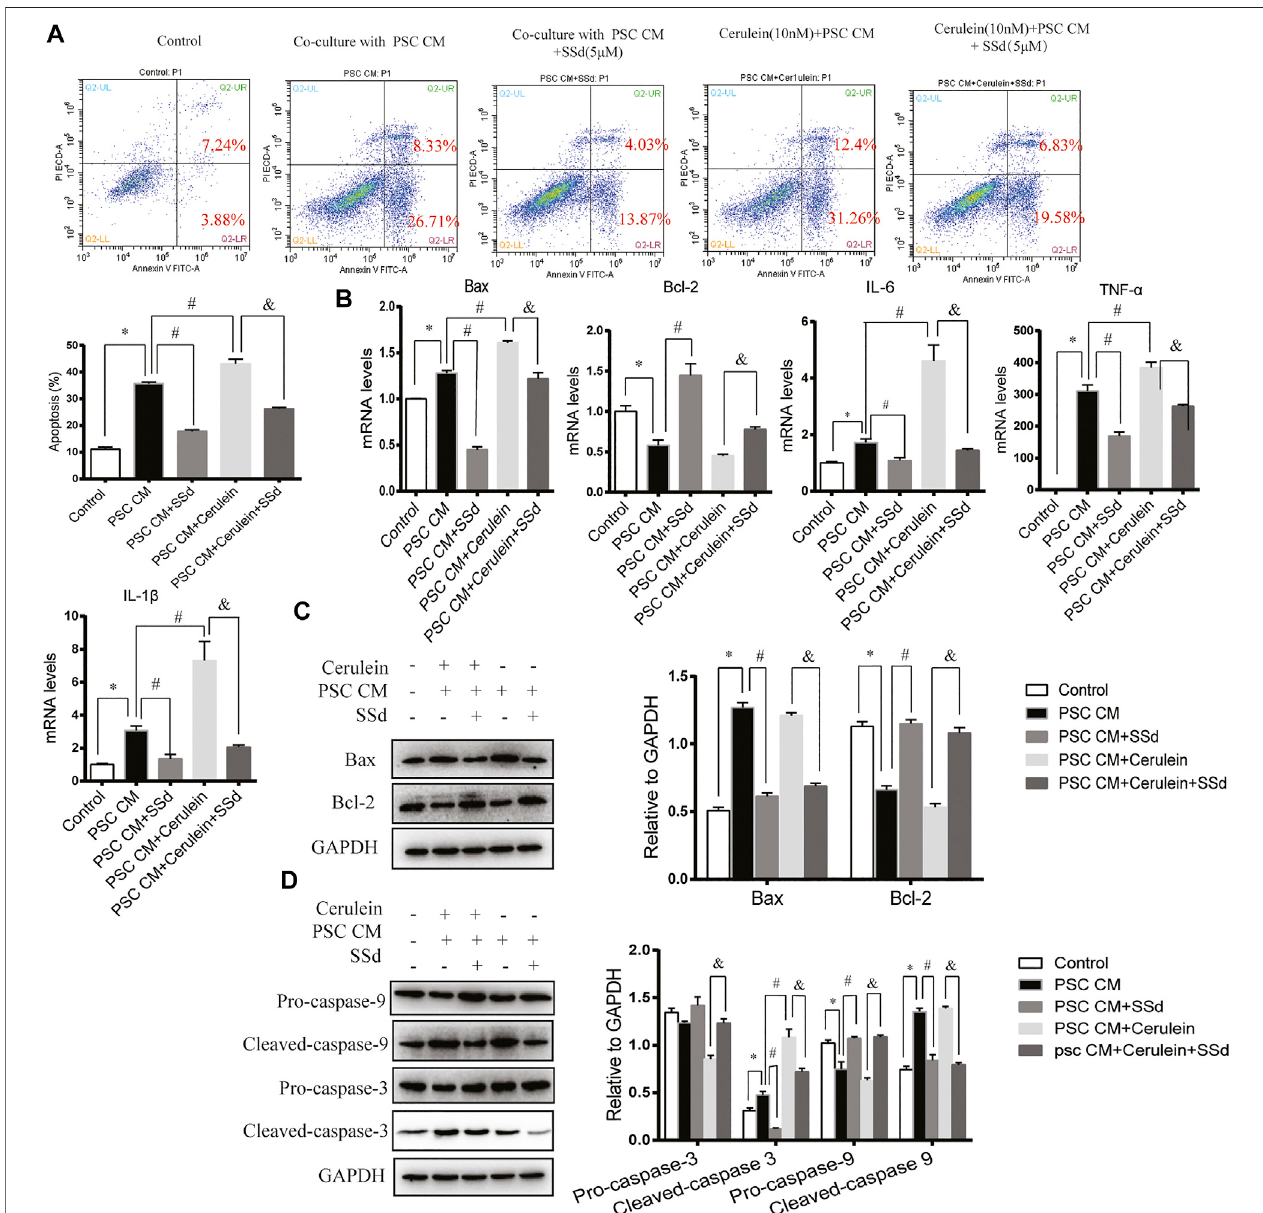
FIGURE 5 | SSd reduced apoptosis and in fl ammation of AR42J cells induced by PSCs-CM or PSCs-CM and cerulein combination. AR42J cells were pre-treated with PSCs-CM with 5 μ M SSd or 10 nM cerulein or 10 nM cerulein and 5 μ M SSd for 24 h. (A) Flow cytometry analysis of apoptosis of AR42J. (B) RT-PCR analysis of Bax, Bcl-2, IL-6, TNF- α , and IL-1 β . (C) Western blot analysis of Bax and Bcl-2. (D) Western blot analysis of Pro-caspase-3, Cleaved-caspase-3, Pro-caspase-9, and Cleaved-caspase-9. Data are shown as the mean ± SEM of at least three independent experiments. (* p < 0.05 compared with the control group, # p < 0.05 compared with the PSCs-CM group, and p < 0.05 compared with PSCs-CM + cerulein group).